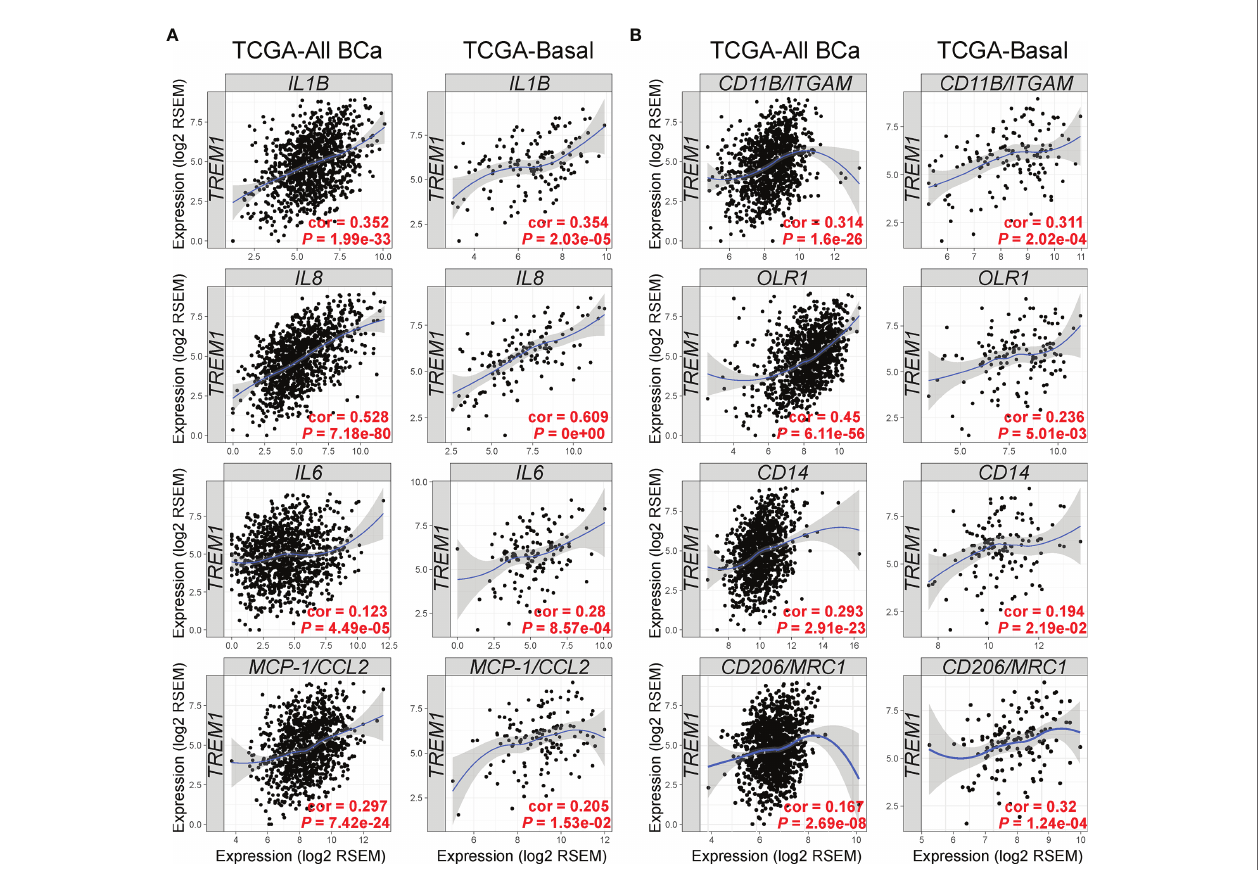
FIGURE 5 | TREM1 correlates with expression of TREM-1-inducible cytokines and markers of tumor-associated myeloid cell populations. The Tumor Immune Estimation Resource (TIMER) (33) was used to analyze gene expression correlations between TREM1 and (A) its cognate cytokines and (B) markers of MDSCs and M2 macrophages. Correlations were analyzed in tumor populations representing all TCGA breast cancer (BCa) cases (n = 1,093) or the Basal-like/TNBC cases (n = 139) only. Spearman ’ s correlation coef fi cient (rho) and P -value are